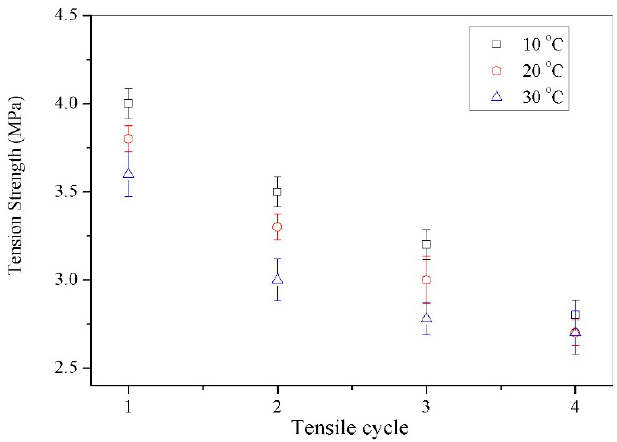
Figure 7. Tension strength values of microcapsules/bitumen samples (microcapsules: 3.0 wt. %, 20 μ m) during a reparative fracture-healing process (four recycles, each healing time: 24 h) under different temperatures.